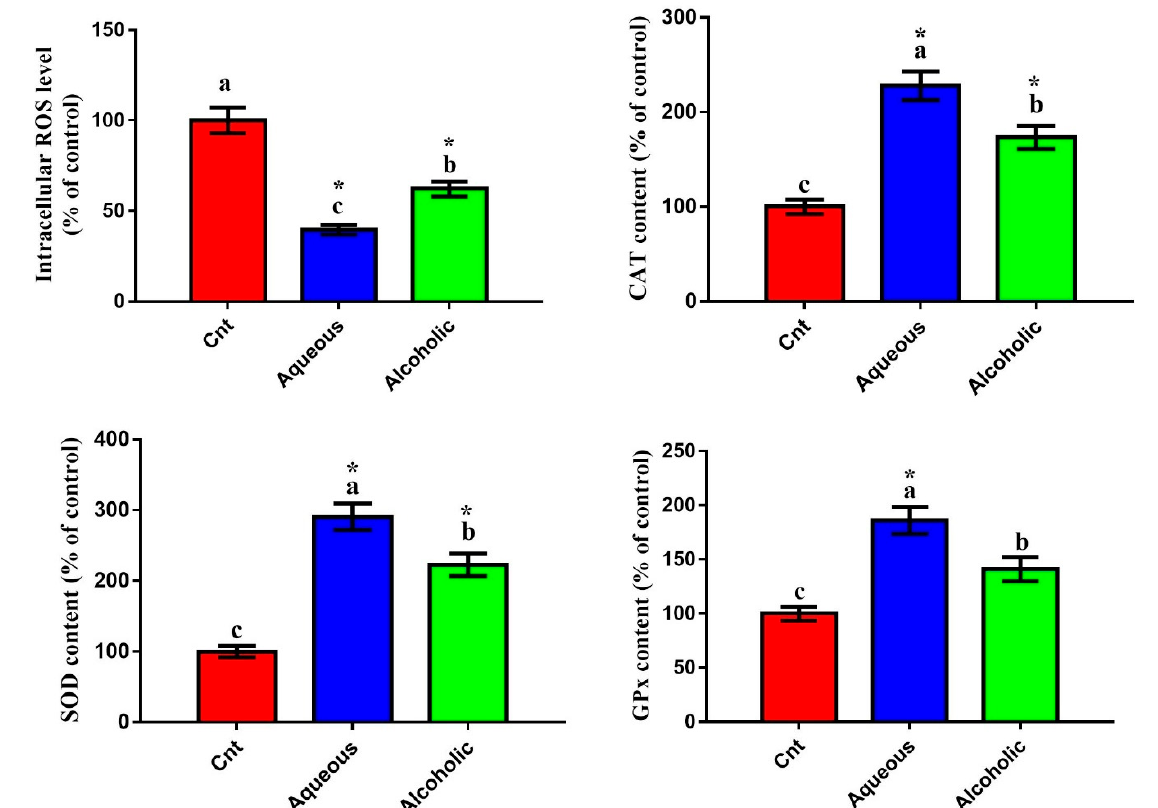
Figure 5. Effect of 5% aqueous and alcoholic larval extracts on intracellular ROS and activities of antioxidant enzymes (CAT, SOD, and GPx) in MCF7 cells. Data are expressed as % of the control ± SEM. Samples were run in triplicate in three independent experiments, n = 5. Groups with different letters are significantly different at p < 0.05. * indicates high significance with respect to the control ( p < 0.01).